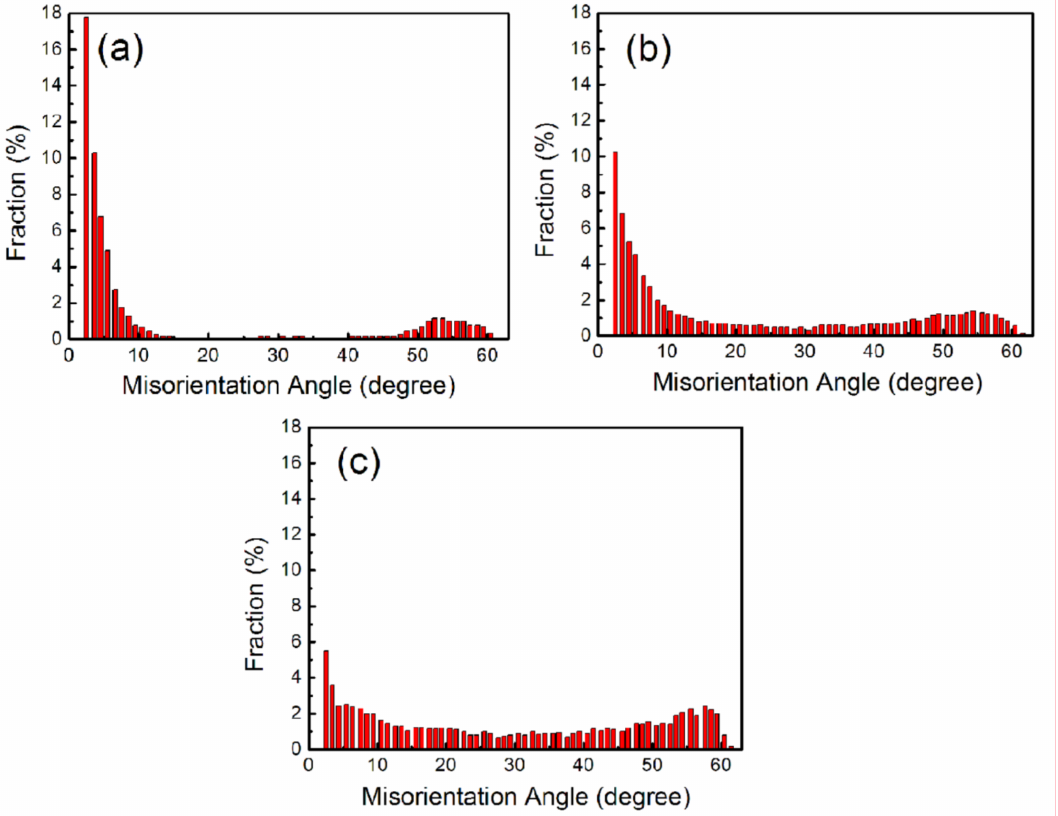
Figure 3. DistributionsofboundarymisorientationanglesofCuARB-processedfor( a )1pass, ( b )3passes, and ( c ) 6